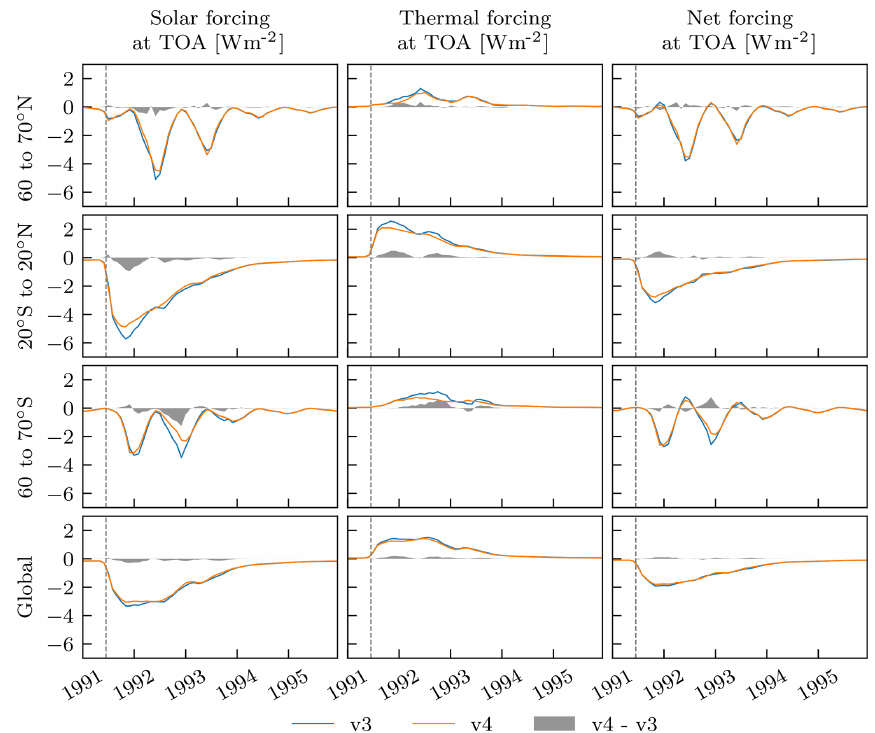
Figure 3. The left column shows the instantaneous solar radiative forcing at the top of atmosphere due to stratospheric aerosols in CanESM5. The blue line shows the forcing from version 3, the orange from version 4, and the gray shaded region indicates the difference in forcing between the two datasets (v4 − v3). The centre column shows the instantaneous thermal radiative forcing at the top of atmosphere, and the right column shows the instantaneous net radiative forcing at the top of atmosphere. Each row shows the results for a different latitude